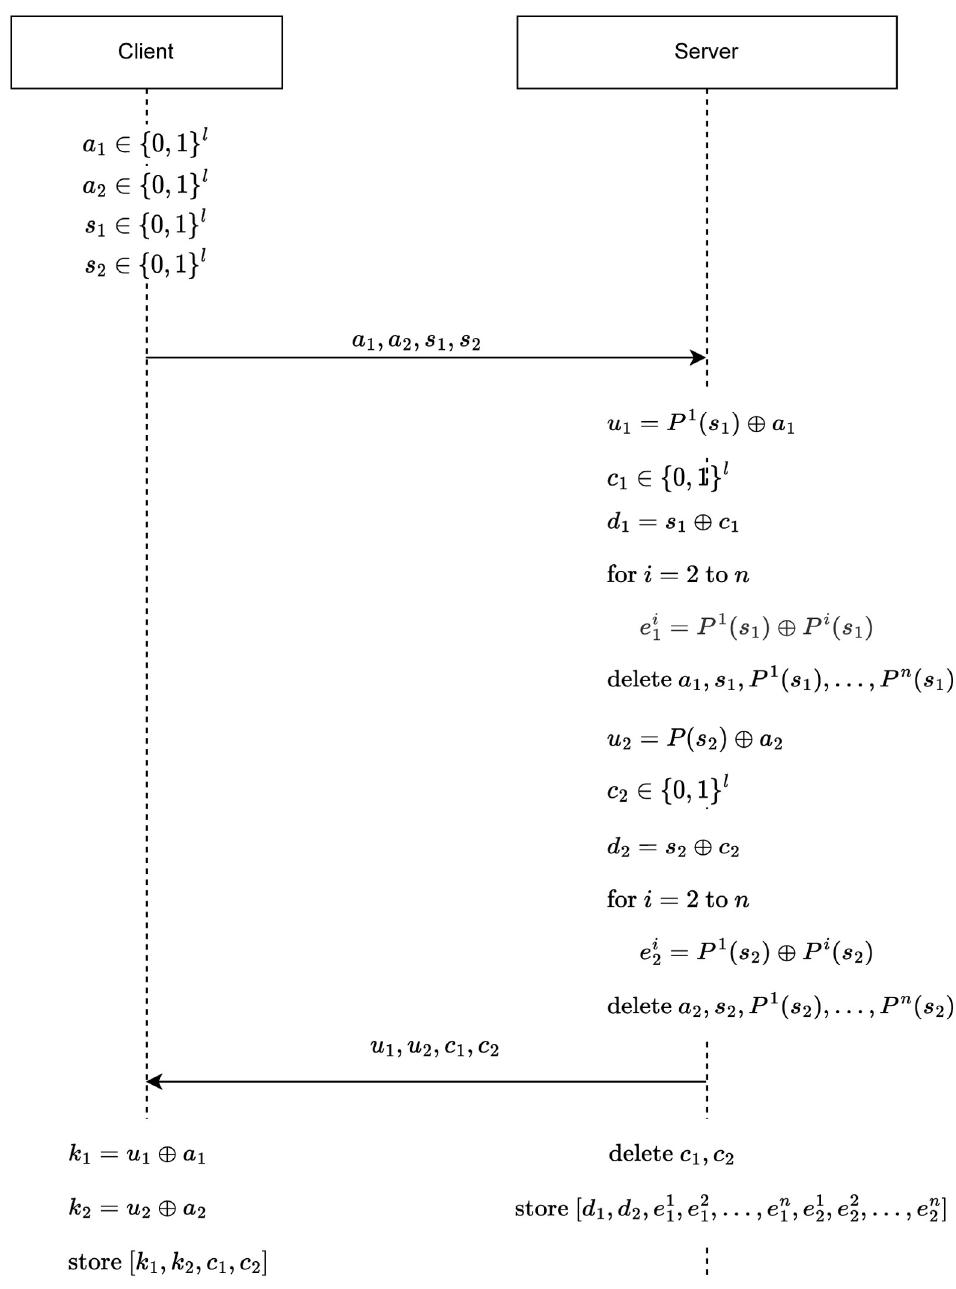
Fig 1. P/Key: Initialization